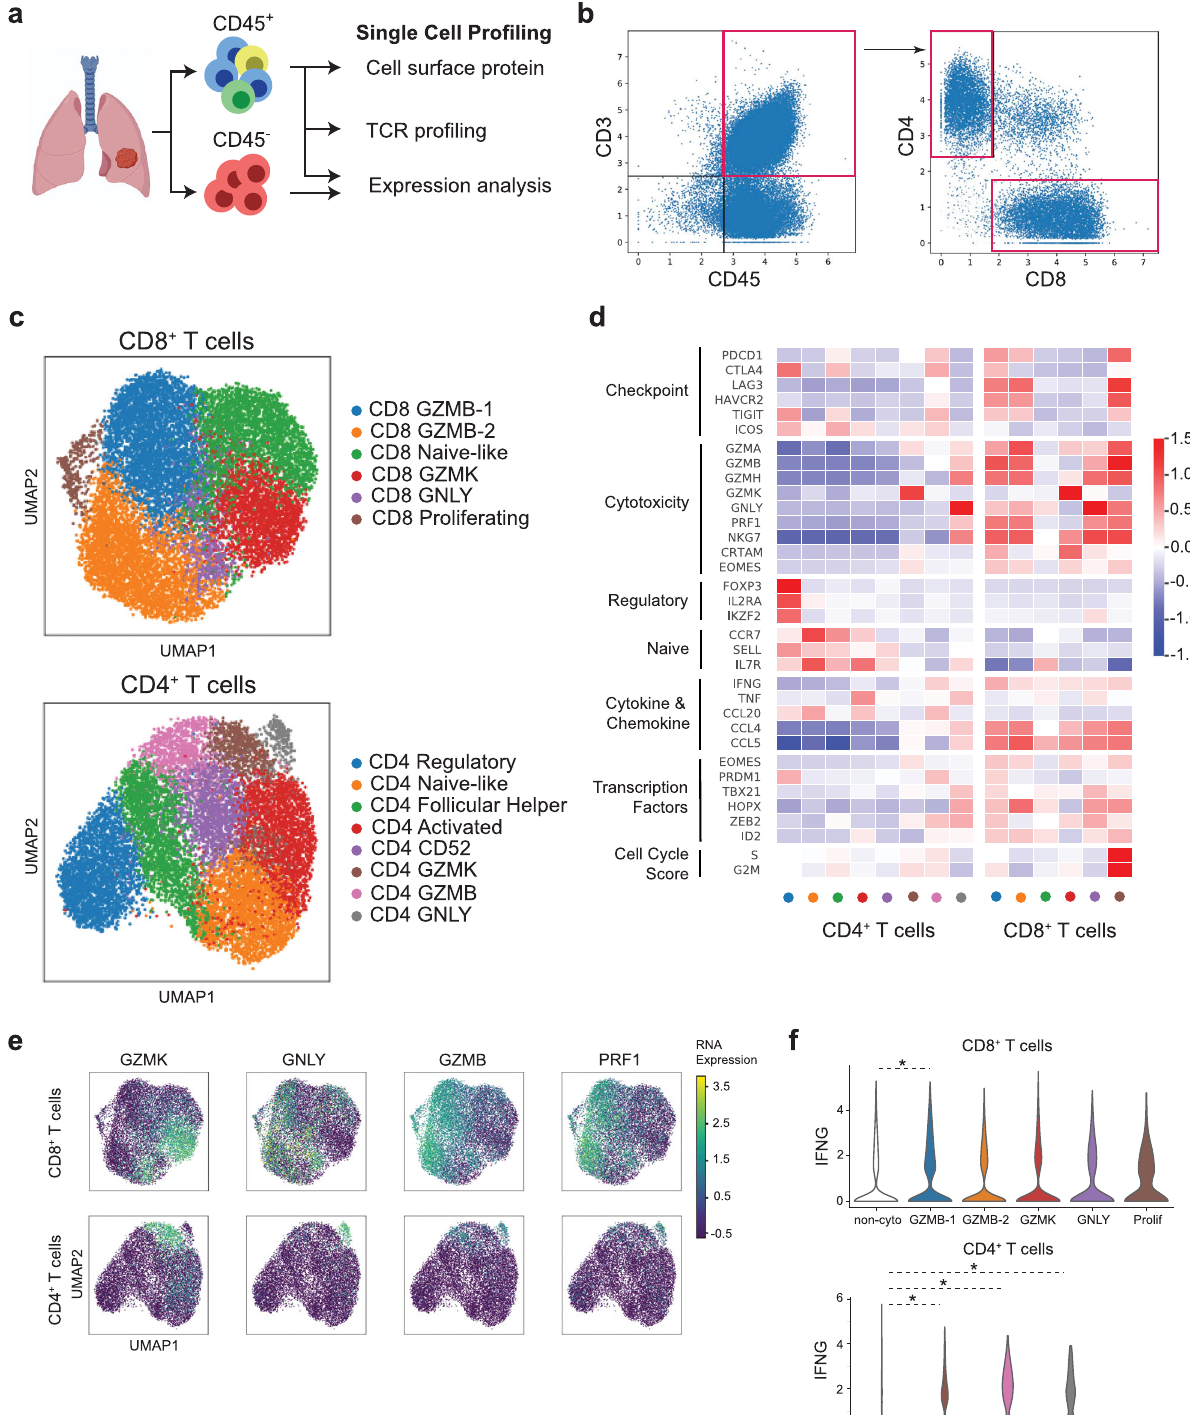
Fig. 2 Single-cell characterization of tumor-in fi ltrating T cells. a Schematic overview of the experimental design ( n = 10 tumor samples). b Gating strategy for the computational isolation of the CD4 + (12,711 cells) and CD8 + T cell compartment (13,935 cells). Expression is shown in centered log-ratio (CLR)-transformed counts. c UMAP projections show a subpopulation of cells in the T cell compartment based on Leiden clustering. Cells were labeled based on the expression of key immune function genes. d Heatmap showing the scaled expression of key immune function genes in the T cell compartment. e UMAP projections show the distinct patterns of expression for the cytotoxic genes PRF1 , GZMB , GZMK , and GNLY . f Violin plots show the log-transformed RNA expression of IFNG in the Leiden clusters. *Represents clusters with signi fi cantly different expressions ( p < 0.05) compared to the other clusters after Bonferroni correction (two-sided Wilcoxon Rank-Sum). For top panel: p GZMB-1 = 1.04 × 10 − 23 , n = 13,935 cells; bottom panel: p = 4.32 × 10 − 12 , p = 5.92 × 10 − 44 , p = 1.40 × 10 − 5 , n = 12,711 cells). Source data are provided as a Source Data fi GZMK GZMB GNLY